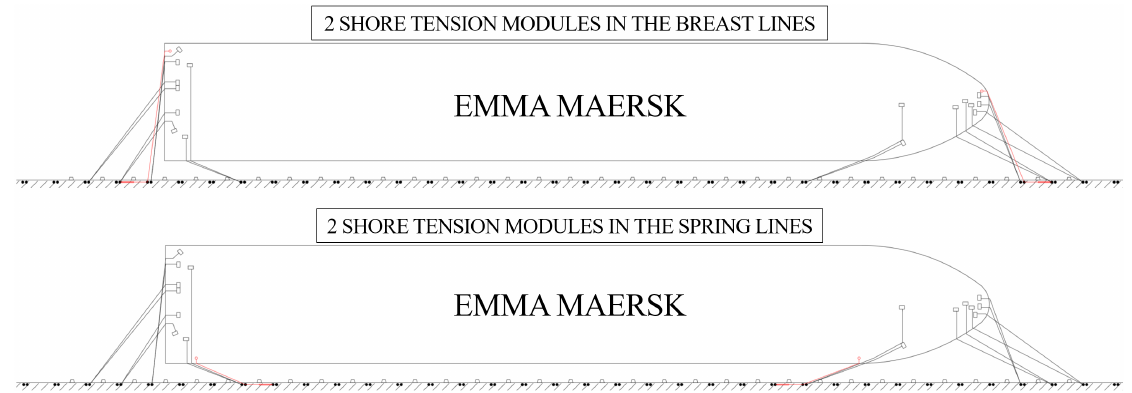
Figure 21. Position of the 60 t ShoreTension ® modules for the Emma Maersk (red